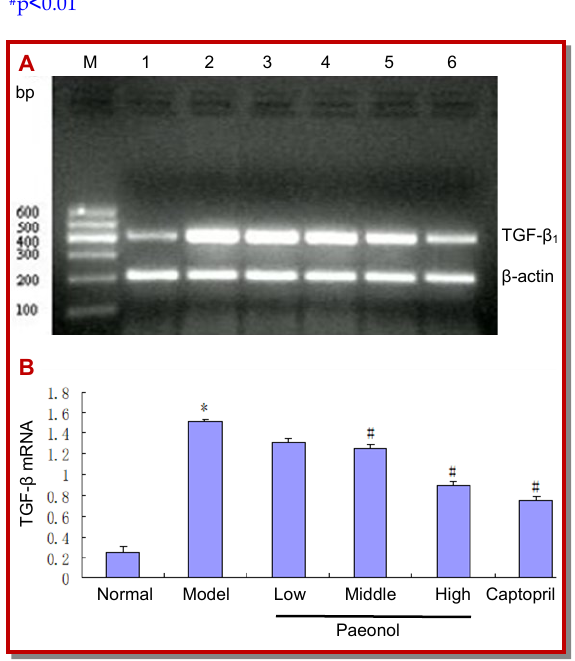
Figure 1: Cell viability was detected in cardiac fibroblasts in each group by the method of MTT. Compared with the normal control group *p < 0.01; compared with the model group, # p < 0.01